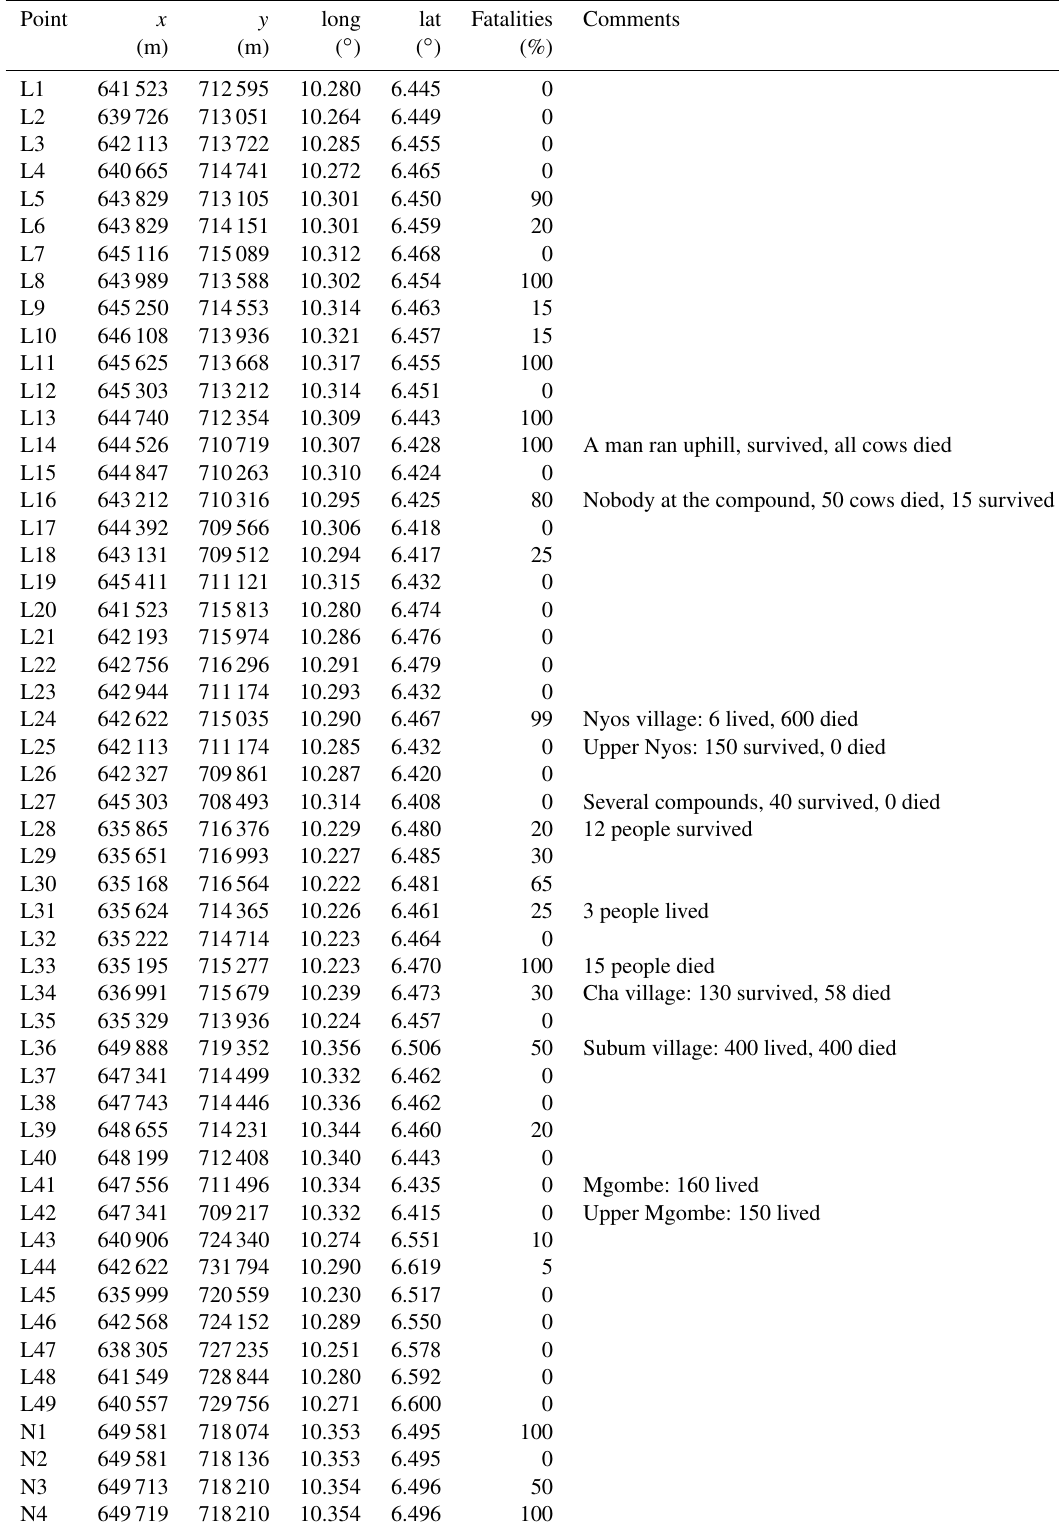
Table 1. List of affected points with coordinates and percentage of observed fatalities. (x,y) coordinates are in UTM zone 32N (datum WGS84). Points starting with an L have been digitalised from Le Guern et al. (1992); points starting with an N were obtained by the authors after interviewing survivors in situ. Comments as reported by Le Guern et al. (1992) in their Table